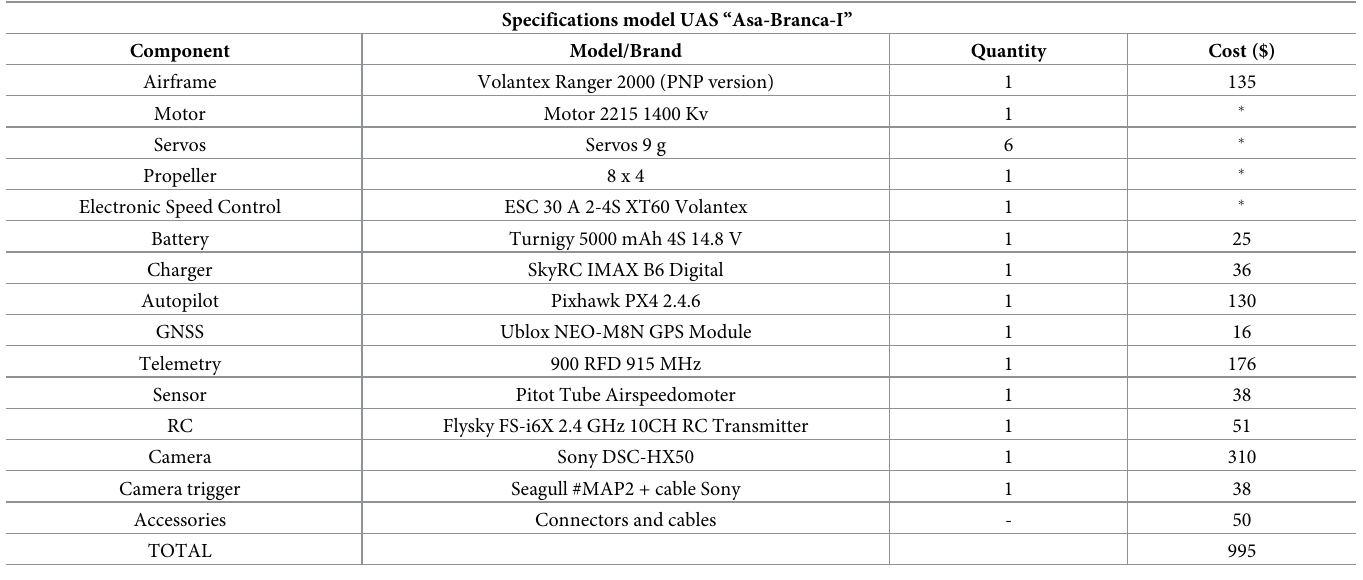
Table 2. Asa-Branca-I costs (USD) based on prices available on the internet in November 2019. Specifications model UAS